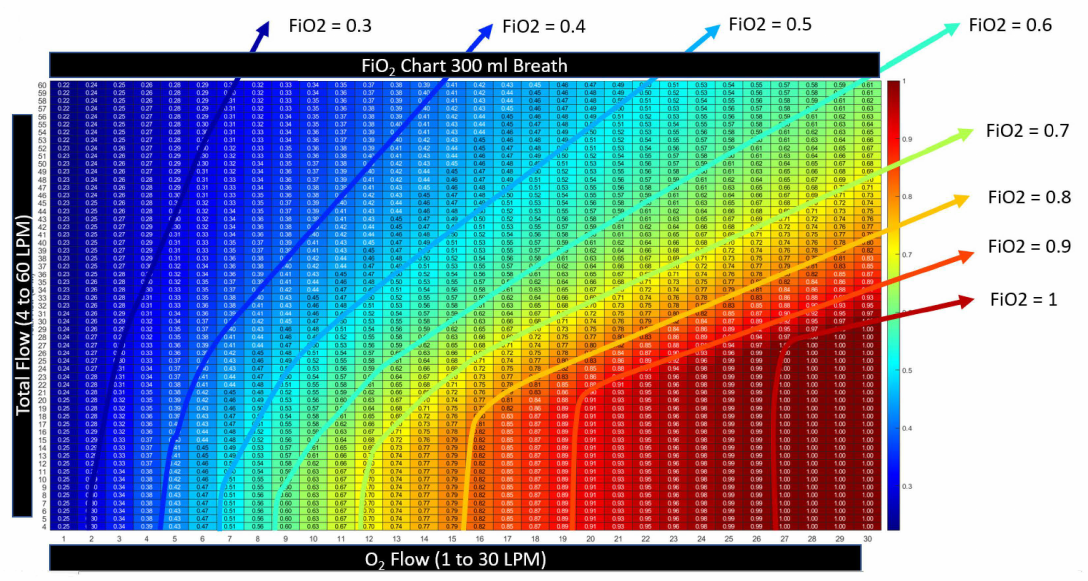
amount of O 2 flow added into the circuit and the tracheal F i O 2 for a single size (300 mL) amount of O fl ow added into the circuit and the tracheal F (cid:2870) breath. The simplest way to control the tracheal F i O 2 is explained below in an algorithm below in Section 3.4.2.